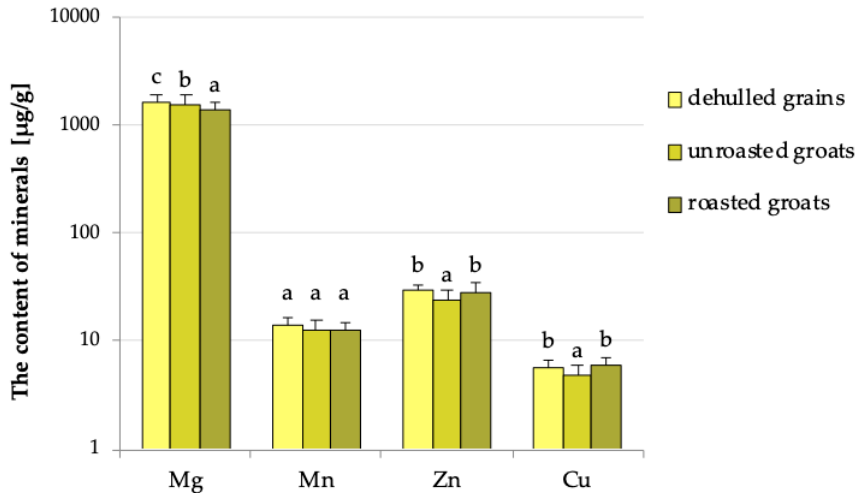
Figure 2. The content of minerals in dehulled buckwheat grains and groats. a, b, c—values referring to individual minerals and denoted by the same letters are not statistically different at p < 0.05.